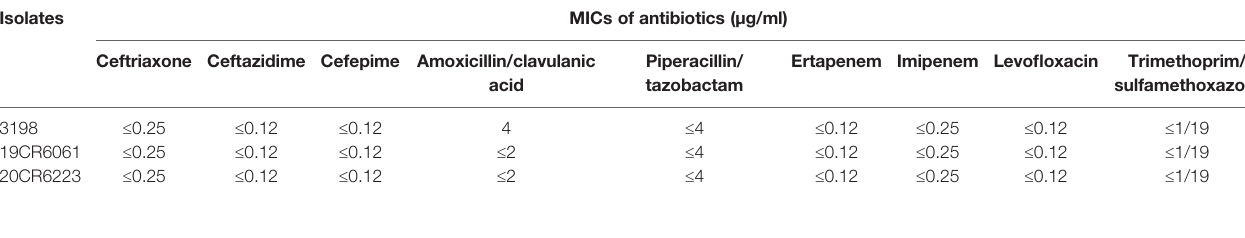
TABLE 3 | The distribution of virulence genes of S. enterica subsp. diarizonae isolates. Classi fi cations